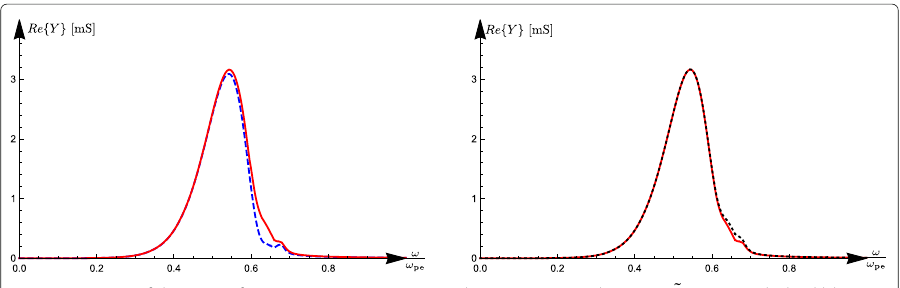
Fig. 5 Spectra of the pMRP for constant N max = 200 and R ∞ = 40 R S and varying ˜ M max = 0 (dashed blue line), ˜ M max = 1 (bold red line), and ˜ M max = 2